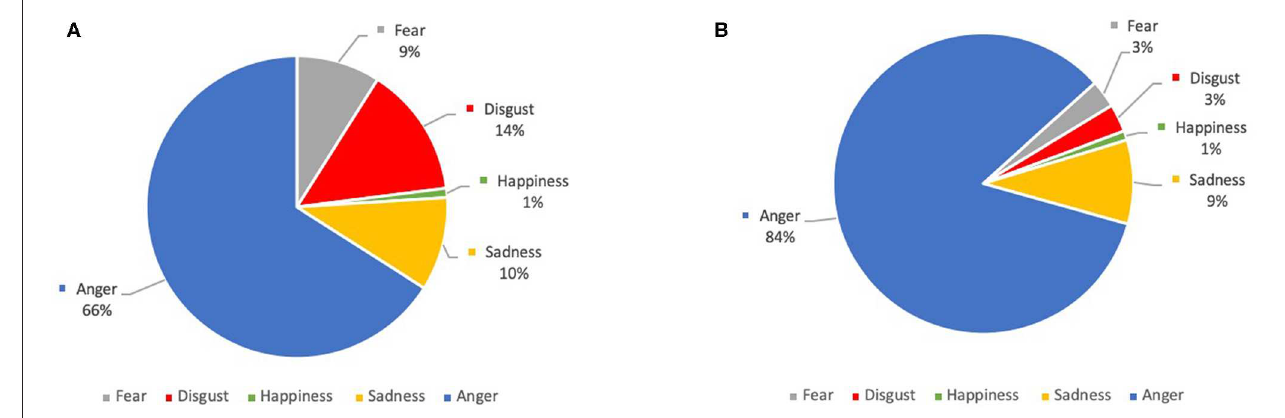
FIGURE 10 | (A) Reactive anger male. (B) Reactive anger